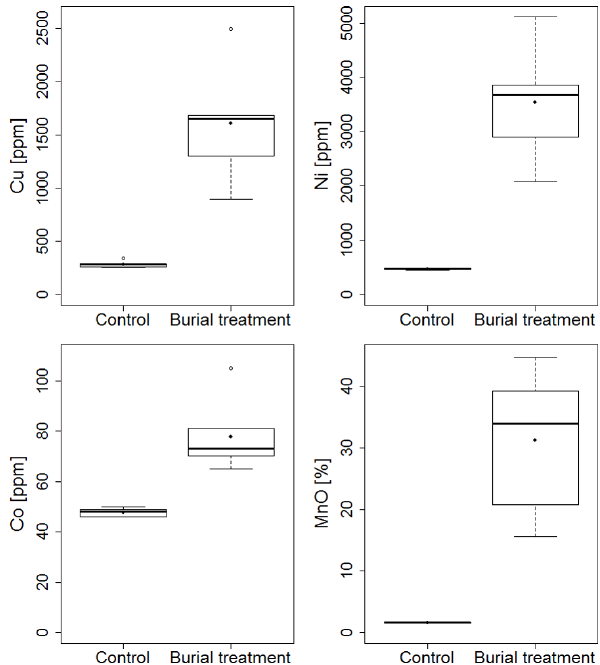
Figure 2. Box and whisker plot of solid-phase metal contents mea- sured in the 0–1cm layer of the Control and the added crushed nod- ule layer of the Burial treatment. Black lines depict the median, whereas dots indicate the mean of the